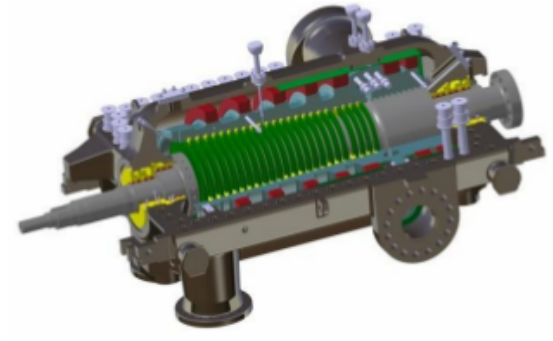
Figure 1: HP cross section of 18K390 steam